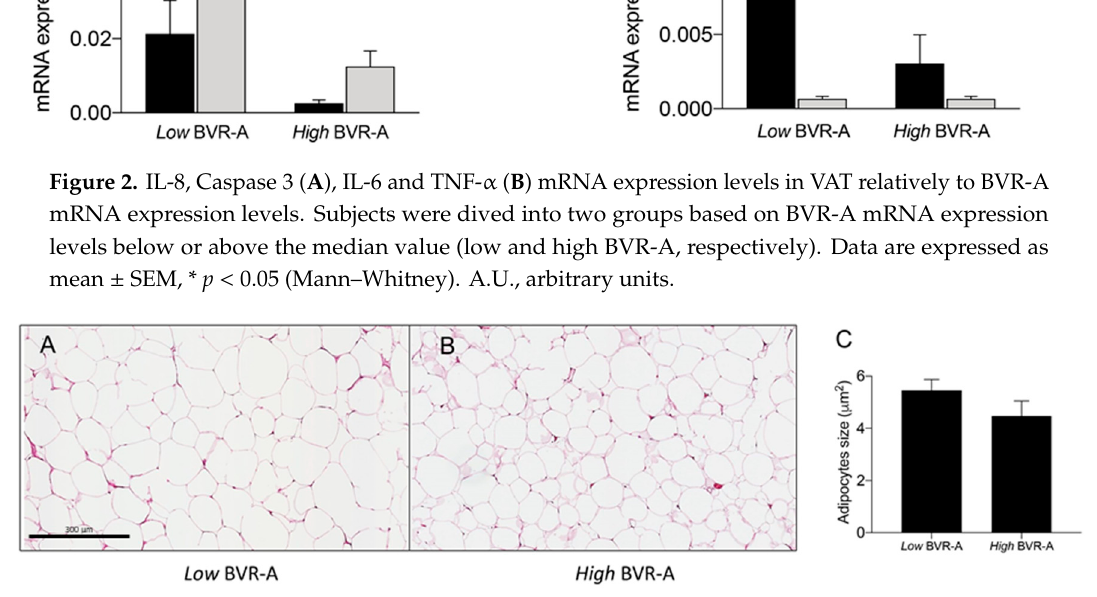
Figure 3. Images showing adipocytes of two representative study participants belonging to low BVR ‐ A group ( A ) and high BVR ‐ A group ( B ). In ( C ) quantification of the cross ‐ sectional area (CSA) expressed as mean ± SEM.